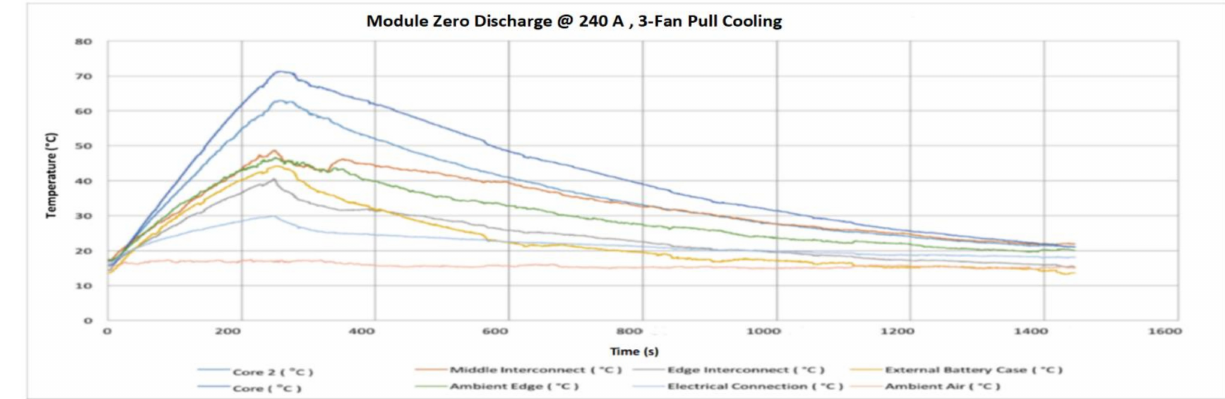
Figure 14. Module zero discharge, 240 A 3-fan pull cooling.